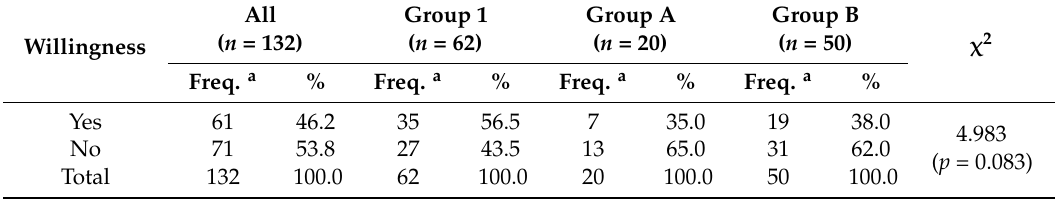
Table 8. Difference of willingness to invest in FCO projects among Group 1, A, and